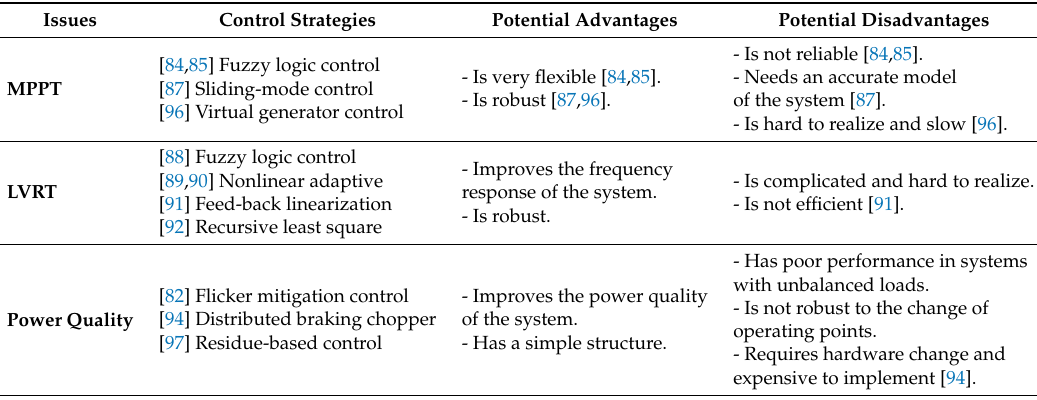
Table 4. Supplementary controllers for Type IV wind